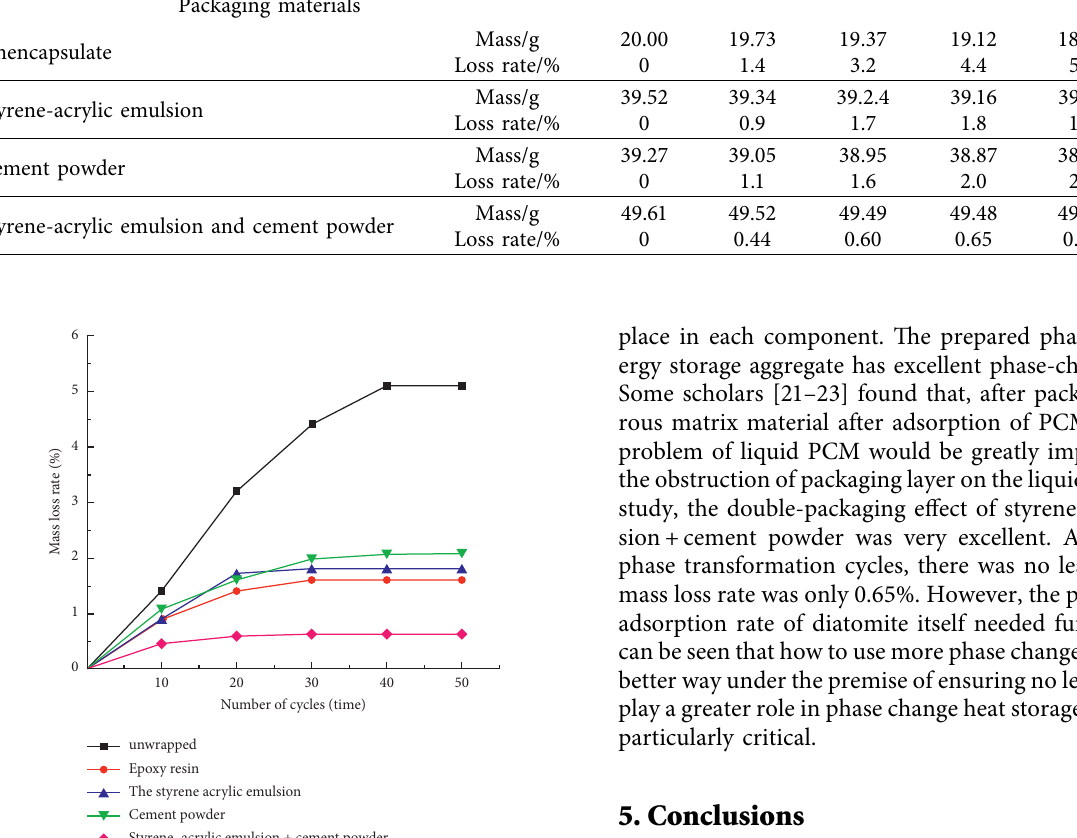
Figure 12: DSC curves of TD-MA-LA and phase change diatomite. Table 1: Changes of mass and loss rate of phase change expanded perlite under different encapsulation methods. Cycle number